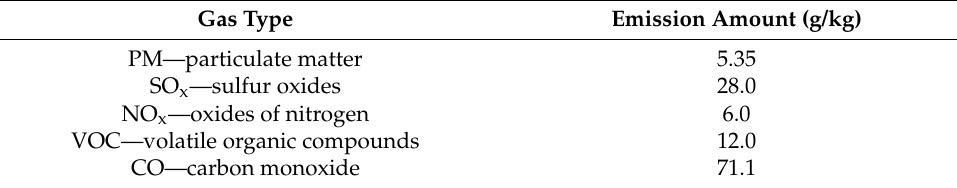
Table 10. The amount of gas emissions released during tire